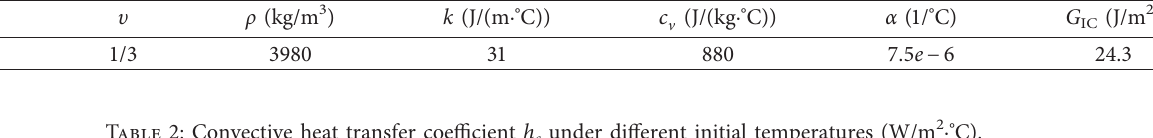
Table 1: Material properties of Al